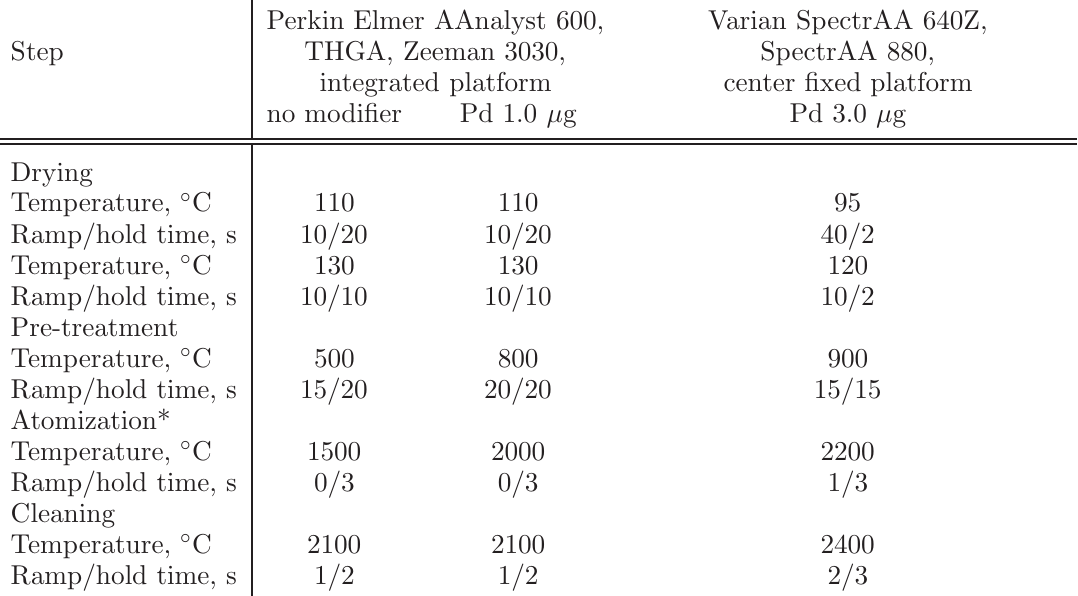
Table 1 Instrumental conditions for determination of lead by